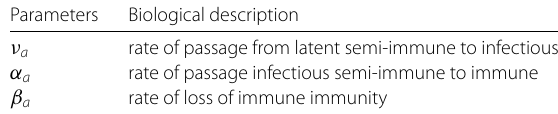
Table 3 Parameters common to non-immune and semi-immune Parameters Biological description (cid:9) h constant recruitment rate of human (it also includes births) p probability for a new recruit to be non-immune 1 – p probability for a new recruit to be semi-immune Table 4 Parameters for semi-immune hosts Parameters Biological description